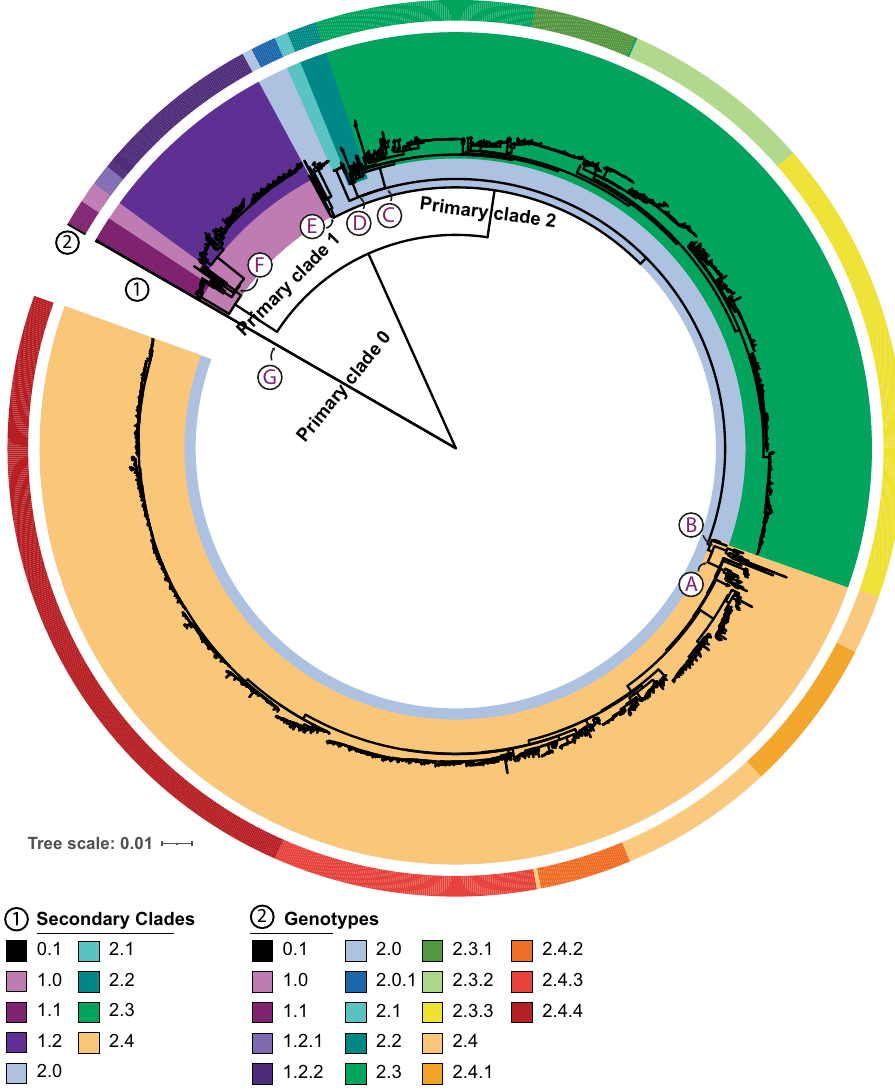
Fig.1|Genotypingschemefor Salmonella ParatyphiA. Theschemeiscomposed of three primary, nine secondary and 18 genotypes on a phylogenetic tree of 1379 isolates. The 9 secondary clades ashighlighted by the coloring of the inner ring.18